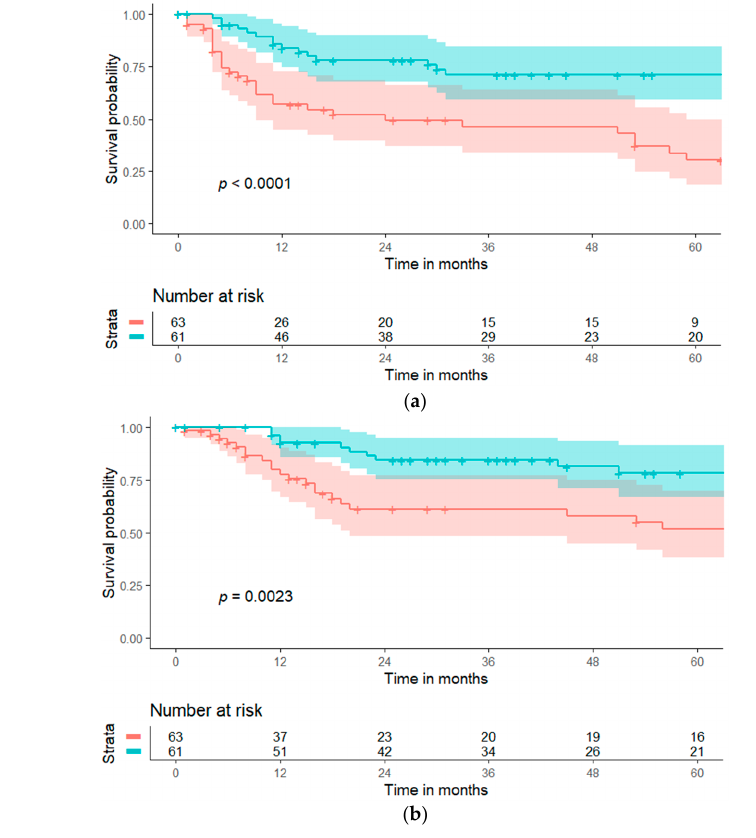
Figure 3. ( a ) Kaplan–Meier curve depicting progression-free survival (PFS) with confidence interval estimates at the timepoint of primary surgery distributed by a pre-therapeutic FARI. A high pre- therapeutic FARI ( ≥ 9.67) was associated with significantly longer PFS. The blue line depicts the co- hort with a pretherapeutic FARI ≥ 9.67 ( n = 61), the red line depicts the cohort with a pretherapeutic FARI < 9.67 ( n = 63). ( b ) Kaplan–Meier curve depicting disease-specific survival (DSS) with